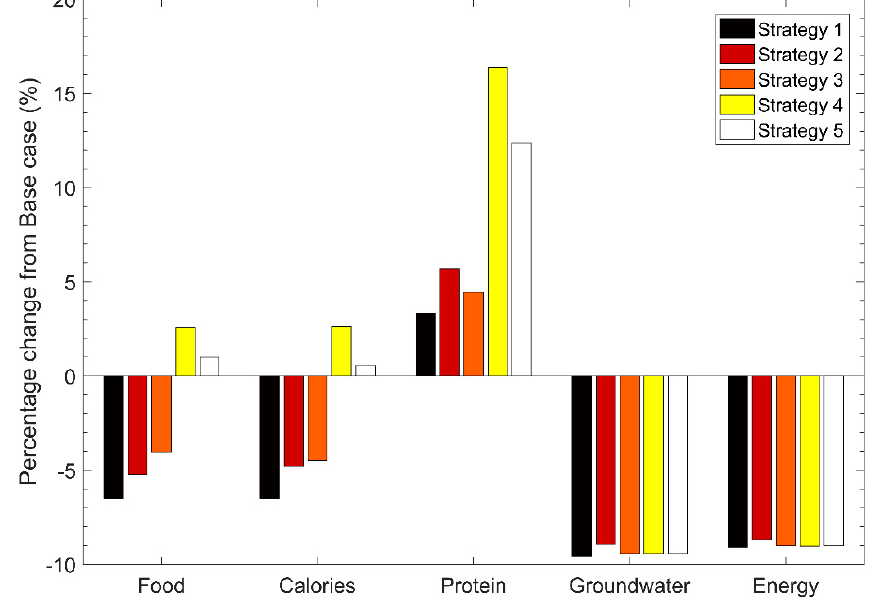
Figure 3. Impact of crop diversification in Scenario C (strategy 5) as compared to Scenario A (base case). In the plot, positive values indicate an increase in the given attribute as compared to the base case and vice versa.